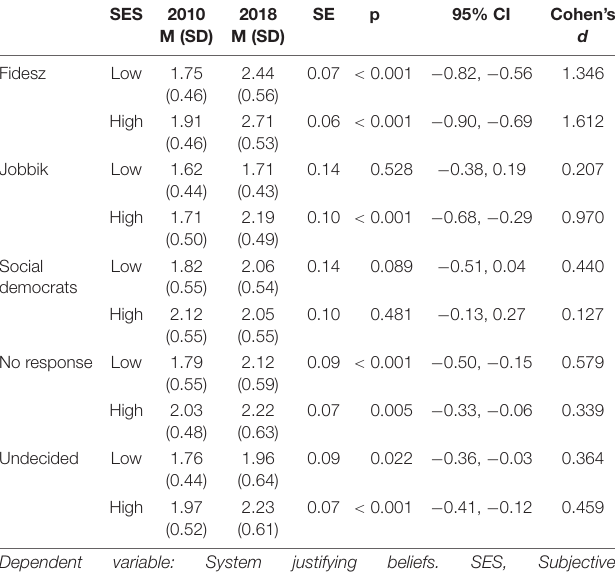
TABLE 2 | Descriptive statistics and effect sizes for comparison between 2010 and 2018 means according to voting intention and